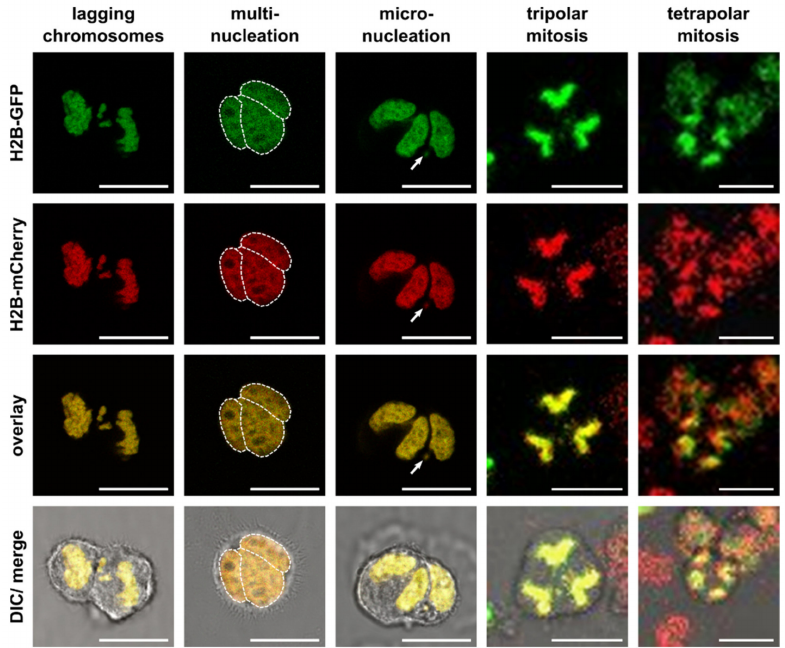
Figure 2. Changes in the karyotype during HST/PR by lagging chromosomes and multipolar divisions with formation of multinucleation and micronuclei and chromothripsis. Shown are rep- resentative images of hybrid cells derived from M13SV1 human breast epithelial cells that were stably transduced with pH2B-GFP (kind gift from Geoff Wahl; Addgene plasmid #11680; http: //n2t.net/addgene:11680; RRID: Addgene_11680) or pH2B_mCherry_IRES_puro2 (kind gift from Daniel Gerlich; Addgene plasmid #21045; http://n2t.net/addgene:21045; RRID:Addgene_21045). The plasmids were used to trace green fluorescing GFP-expressing cells and red fluorescing mCherry expressing cells that eventually fuse by forming yellow fluorescing hybrid cells with constitutive expression of both fluorescence genes. Hybrid cells were cultured on chamber slides (ThermoFisher Scientific GmbH, Schwerte, Germany) and images and time-lapse series were recorded using a Leica TCS SP5 confocal laser scanning microscope (Leica, Wetzlar, Germany). Multiple nuclei in multinucleated cells were marked by a dashed line. The arrow points to a micronucleus. Video files of the tri- and tetrapolar cell divisions can be found in the Supplementary Materials Videos S1 and S2, respectively. Bar = 25 µ